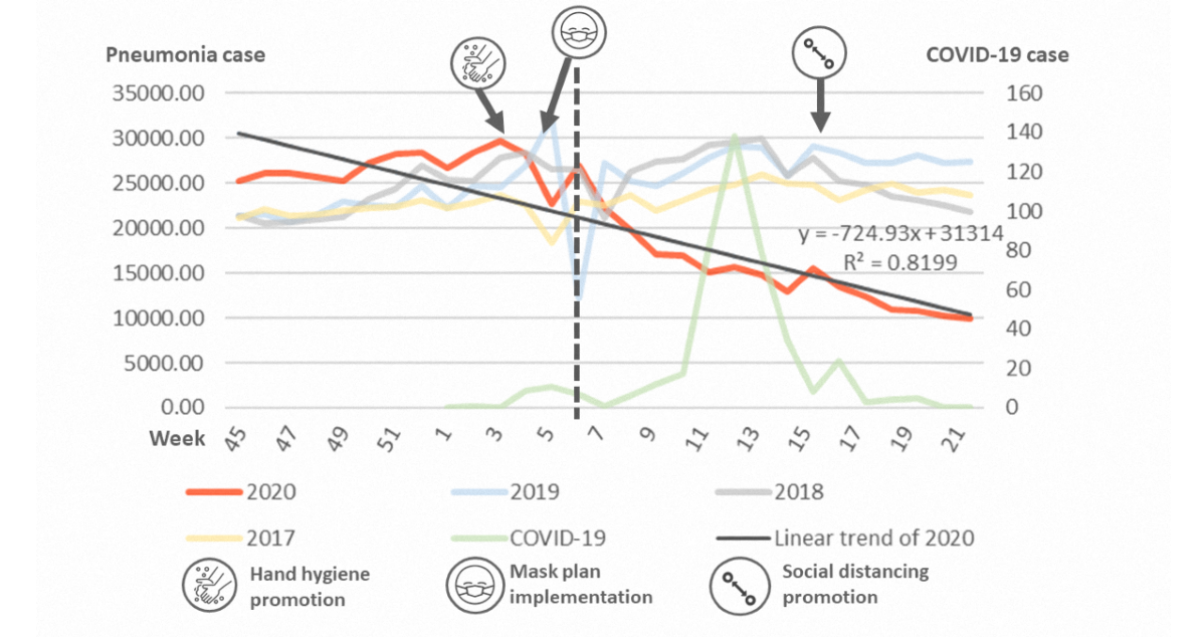
Figure 3. Incidences of all-cause pneumonia in 2017-2020. A dramatic decrease in pneumonia from week 6 of 2020 is shown by the dotted line. COVID-19: coronavirus disease.